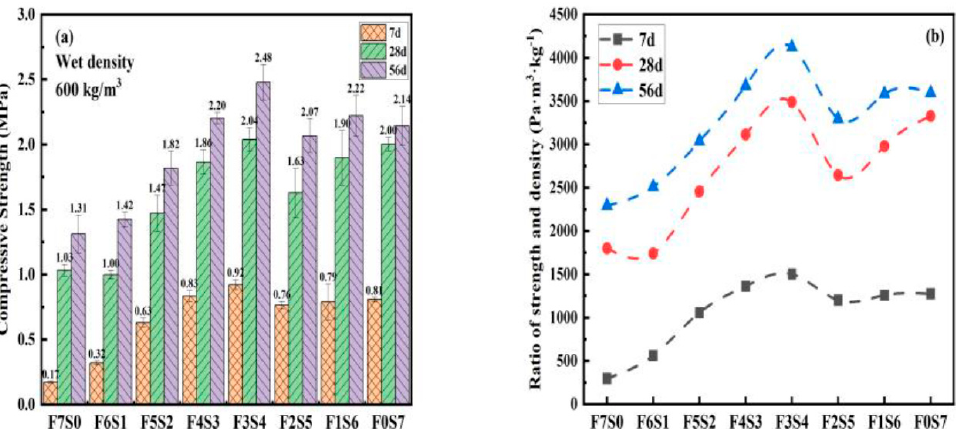
Figure 4. Mechanical performance of the LCFLS: ( a ) compressive strength; ( b ) ratio of strength and density.